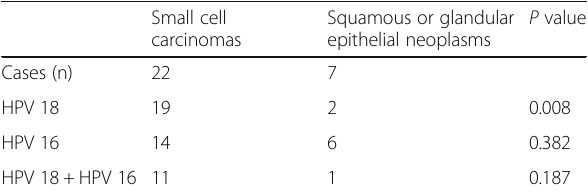
Table 2 HPV infection in small cell carcinoma and other types of epithelial tumors Small cell carcinomas